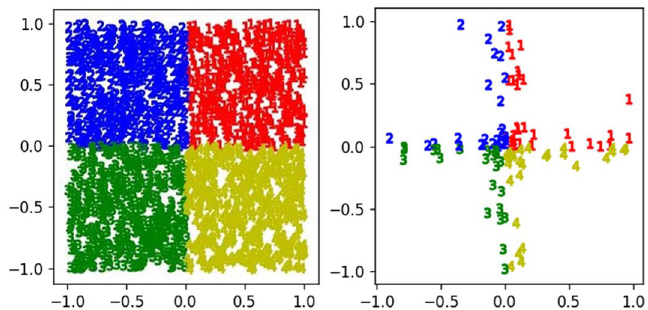
Fig. 3 The distribution of the instances in the artificial data set Square (left), and the distribution of the instances selected from the artificial data set Square (right)